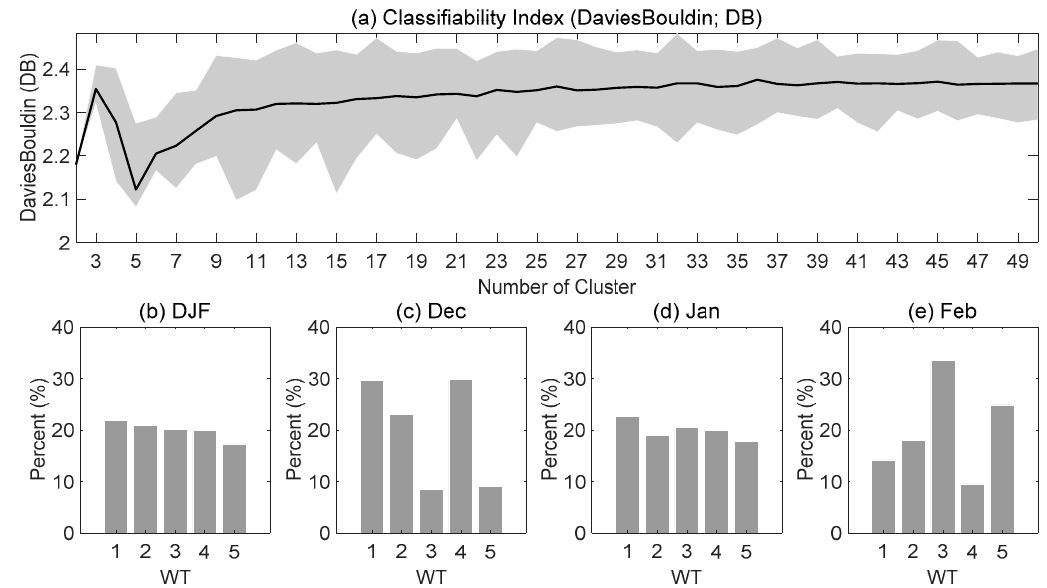
Figure 2. The classifiability index (BDs) results from the k -means clustering of two to 50 clusters (black line) and the 100 repeated calculation results (gray range). The figure shows the ( a ) optimal number of clusters (BD for various numbers of clusters) and percent of days assigned to each clustered weather type (WT) for ( b ) the entire winter season (December–February) and for ( c ) December, ( d )